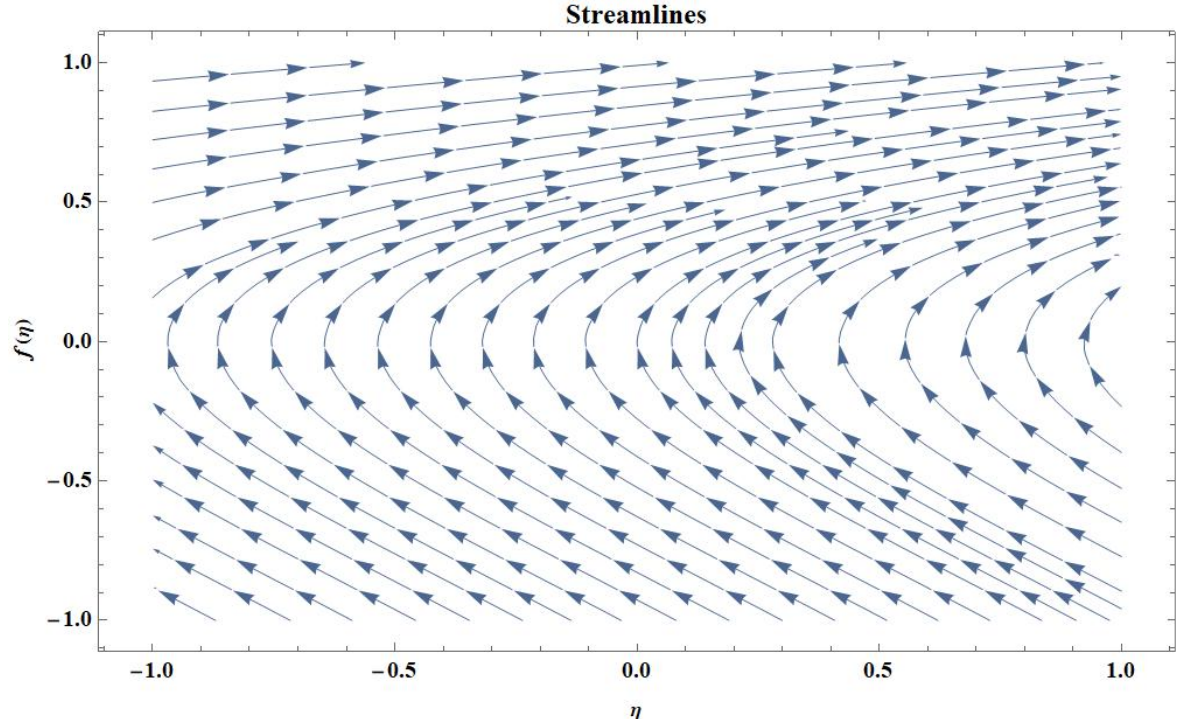
Figure 2. Streamlines of the present flow.